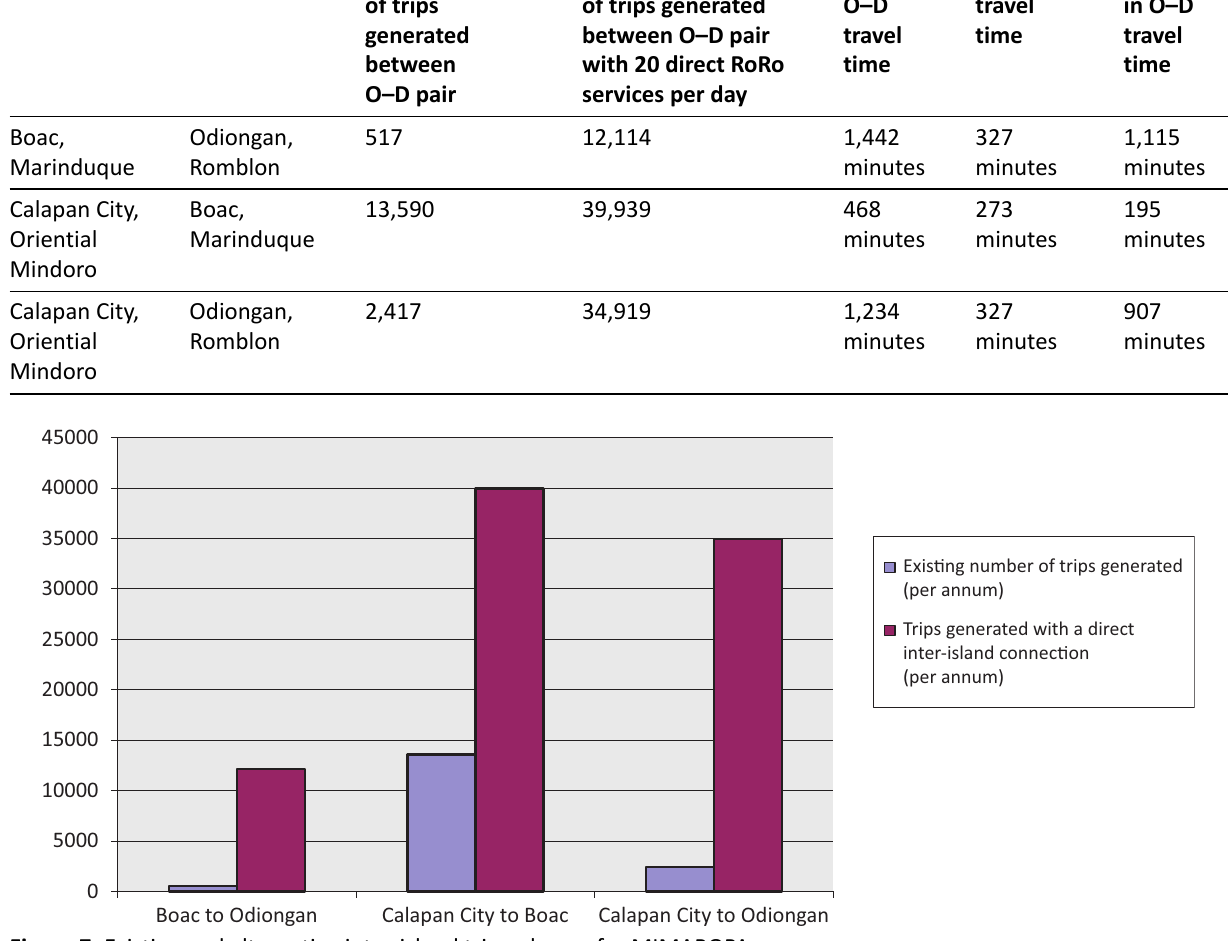
Figure 7. Existing and alternative inter-island trip volumes for